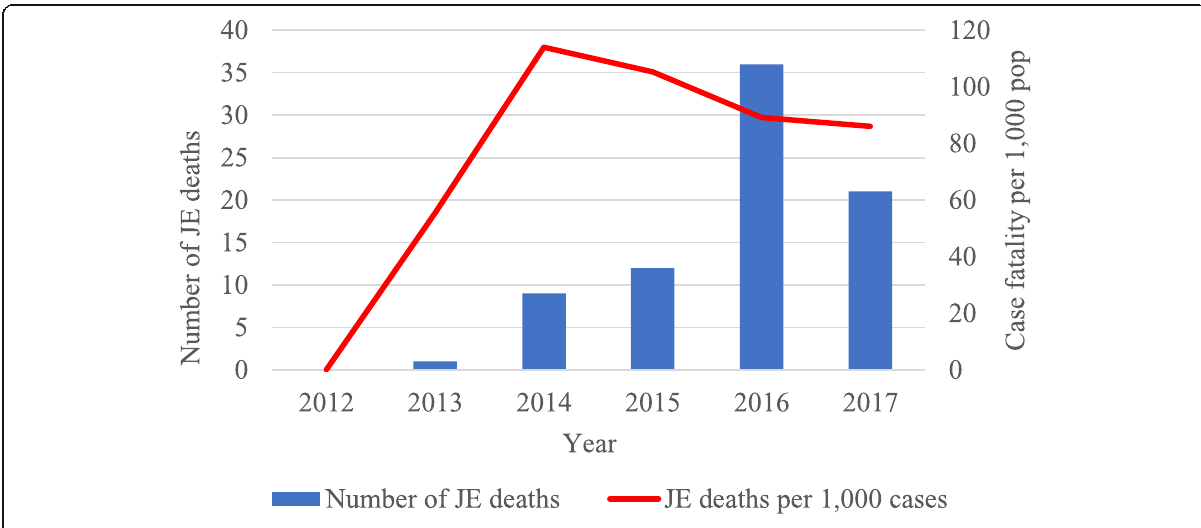
Fig. 2 Annual hospital-reported JE deaths and case fatality rates in Myanmar: 2012 to